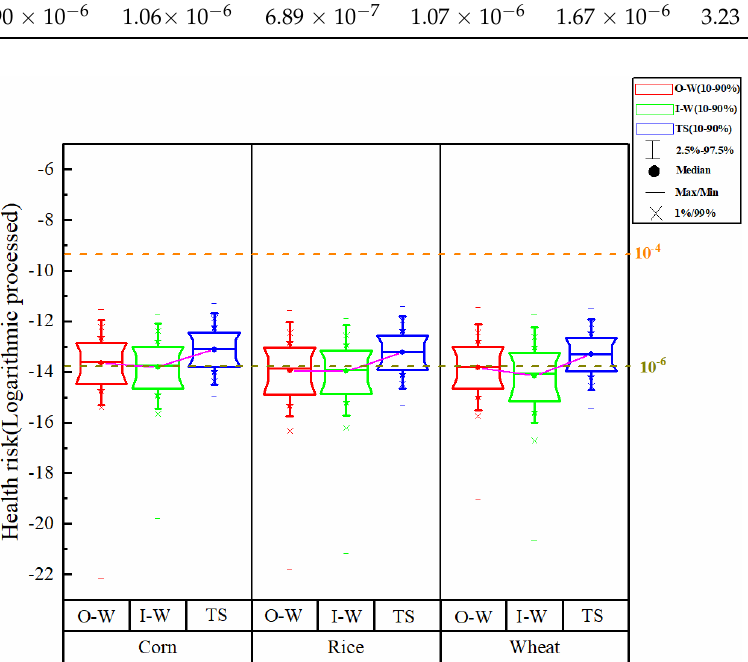
Figure 4. Distribution of health risk values in different storage stages for each grain. Remarks: CO refers to the out-warehousing stage of maize; CI refers to the in-warehousing stage of maize; CT refers to the transporting stage of maize; RO refers to the out-warehousing stage of rice; RI refers to the in-warehousing stage of maize; RT refers to the transporting stage of maize; WO refers to the out-warehousing stage of maize; WI refers to the in-warehousing stage of maize; and WT re- fers to the transporting stage of maize. The rest of the paper is the same.